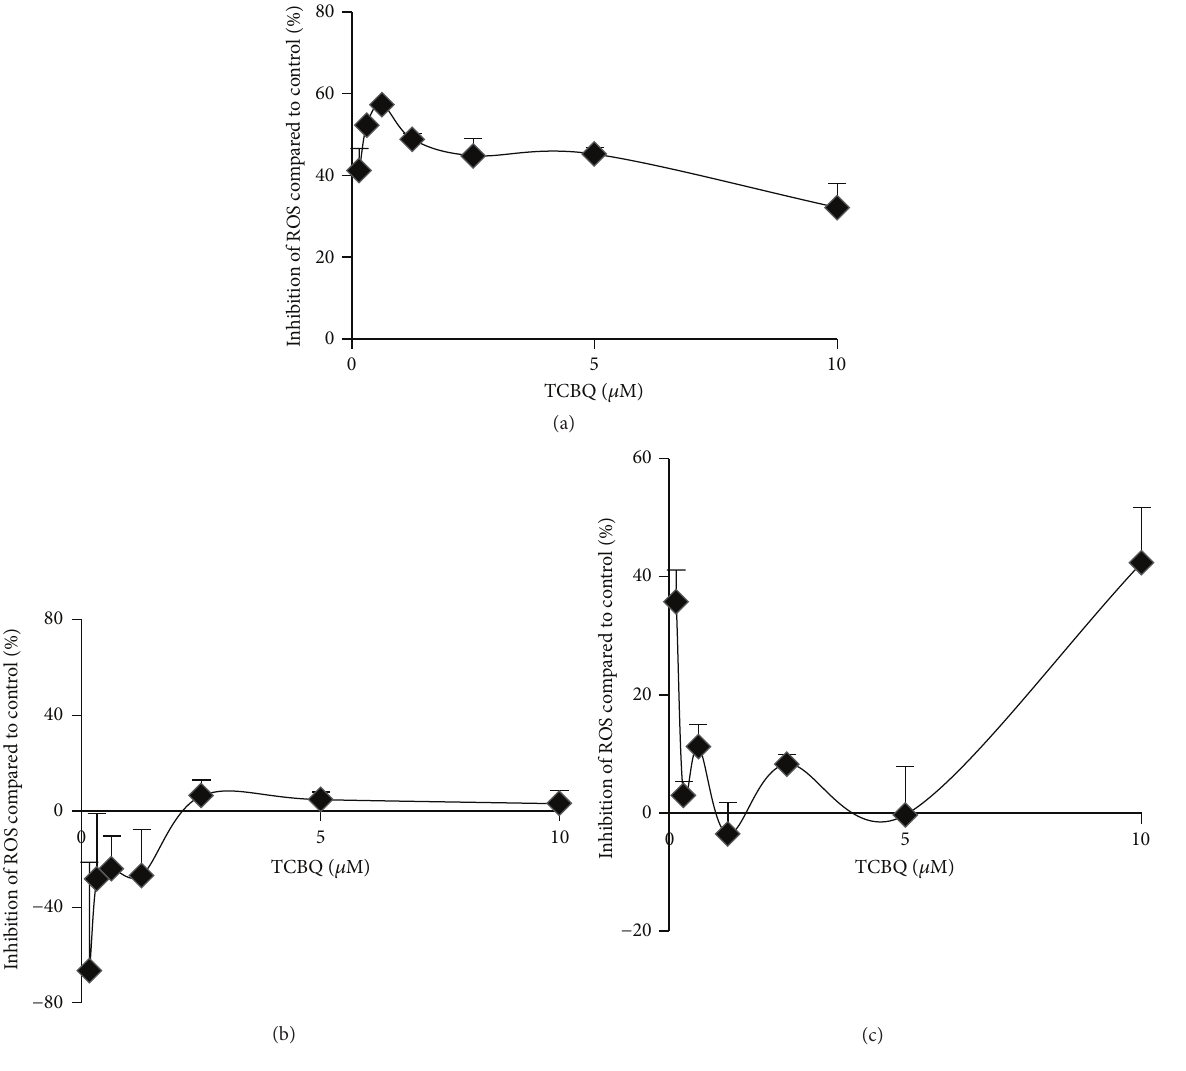
Figure 2: Effects of TCBQ on intracellular ROS production in human breast cancer MCF7 (a), Sk-Br-3 (b), and MDA-MB-231 (c) cells under normoxic condition. The concentration of TCBQ was 0.16 𝜇 M, 0.31 𝜇 M, 0.63 𝜇 M, 1.25 𝜇 M, 2.5 𝜇 M, 5 𝜇 M, and 10 𝜇 M, respectively. Treatment with DMSO was used as negative control. The inhibition of ROS production (%) compared to control was statistically significant at all TCBQ concentrations towards the MCF7 cells, statistically insignificant at all TCBQ concentrations towards the Sk-Br-3 cells, and statistically significant at TCBQ concentration of 0.16 𝜇 M and 10 𝜇 M towards the MDA-MB-231 cells. Statistical analysis was performed by one-way ANOVA with Dunnett’s comparison as posthoc